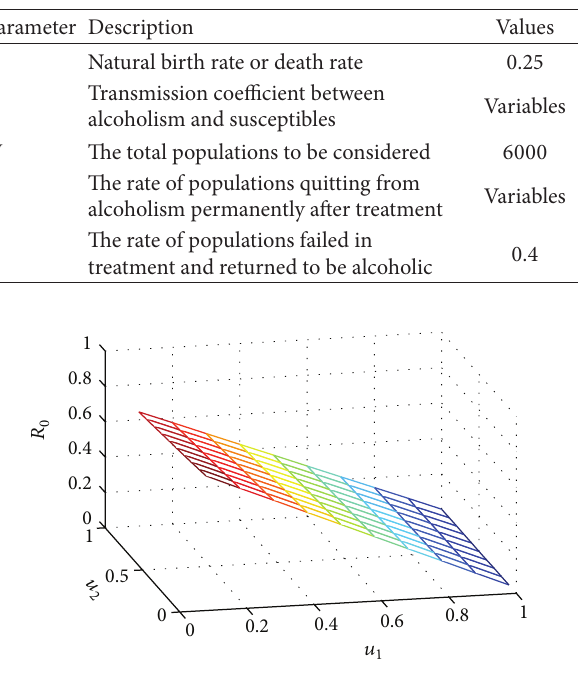
Figure 4: The relationship between 𝑅 0 and two control variables 𝑢 1 and 𝑢 2